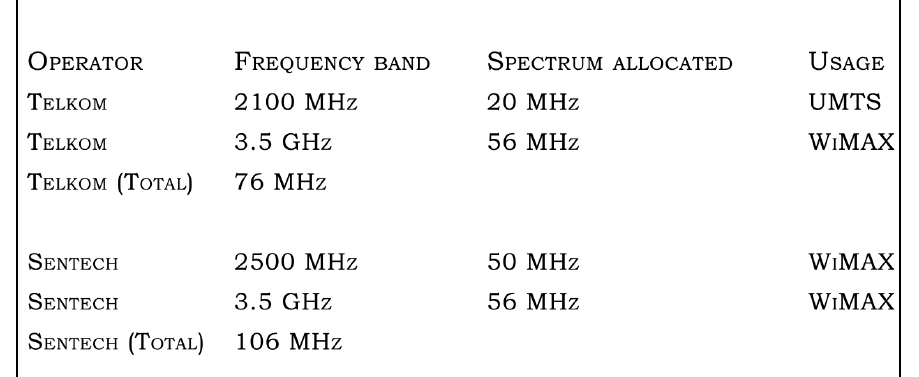
Table 5. Frequency allocations allocated for